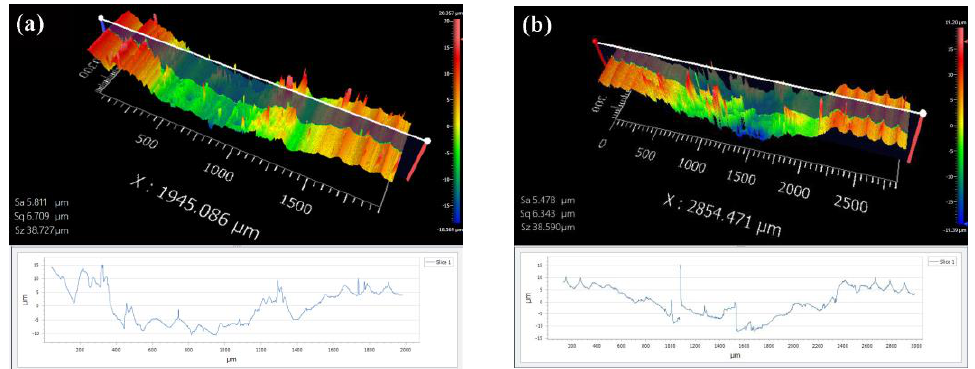
Figure 12. Three-dimensional surface profiles and 2D cross profiles of wear scars for the rail specimen: